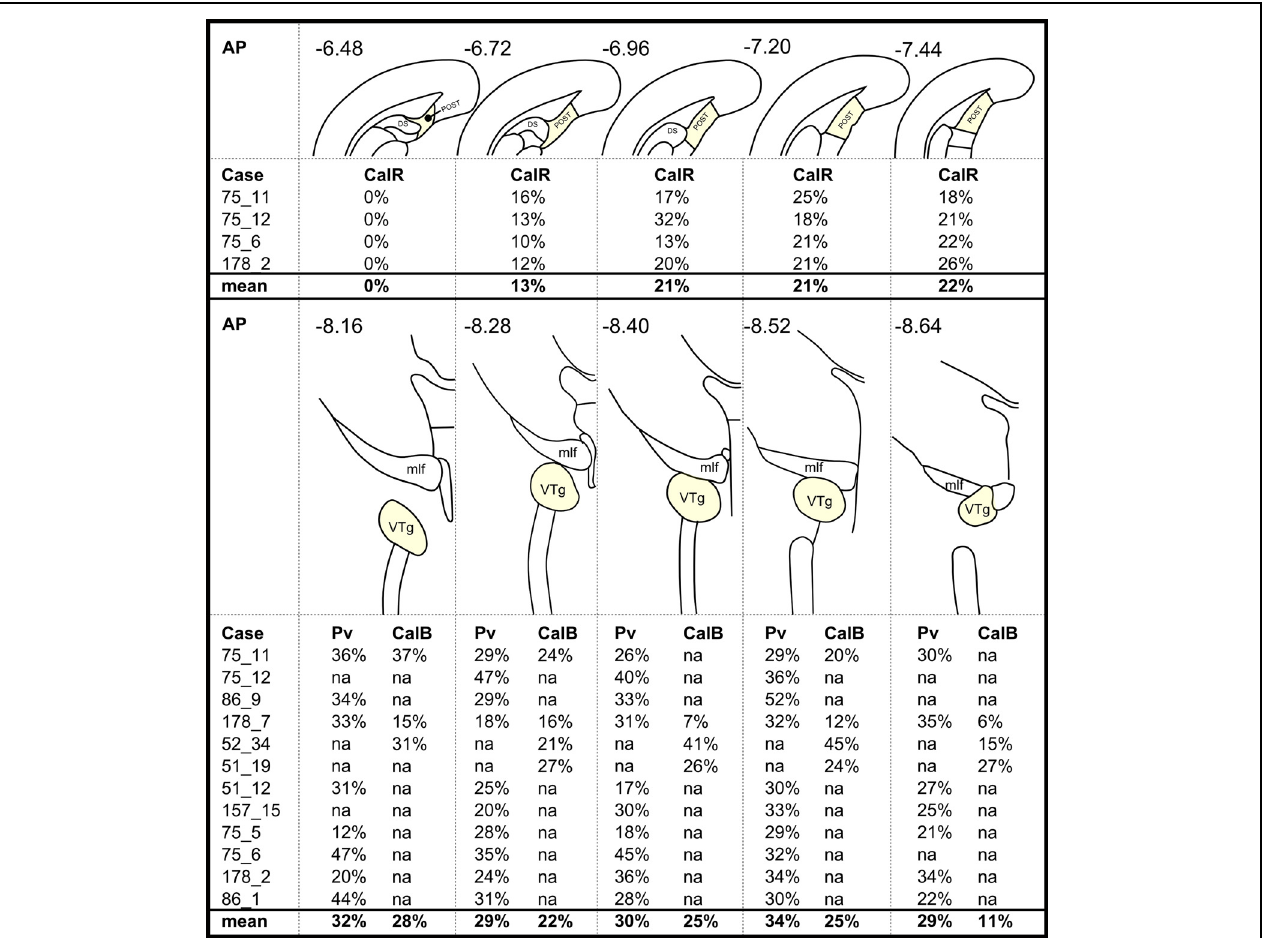
FIGURE 6 | A case-by-case summary showing the percentage of retrogradely labeled neurons that colocalized: (Top) calretinin (CalR) in the postsubiculum (POST) and (Bottom) parvalbumin (Pv)/calbindin (CalB) in the VTg. Percentage values in each column are averages across two hemispheres of a given section and relate to different rostral-caudal locations as